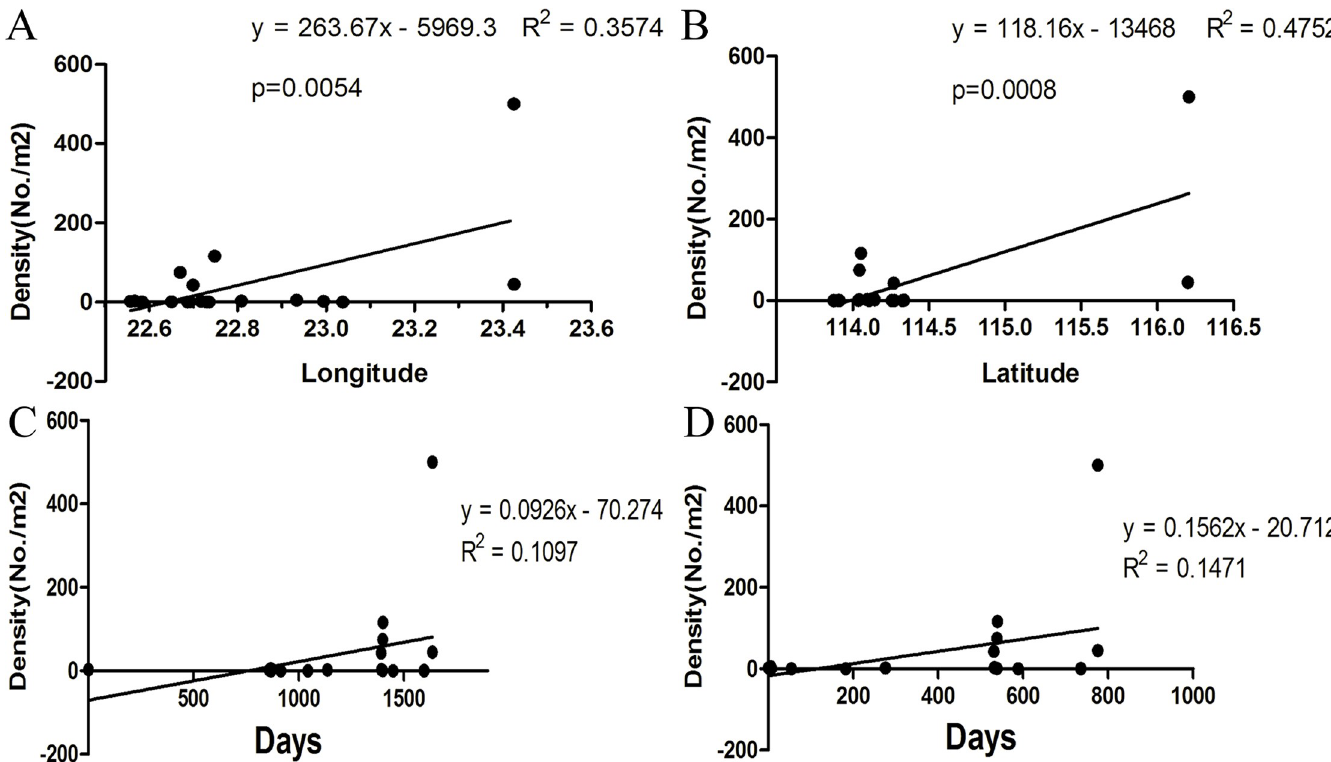
Fig 4. Density shifts in wild populations of red B . straminea in Guangdong province. ( A ) Relation between density and latitude. ( B ) Relation between density and longitude. ( C ) Density changes since 2014. ( D ) Density changes since 2016.